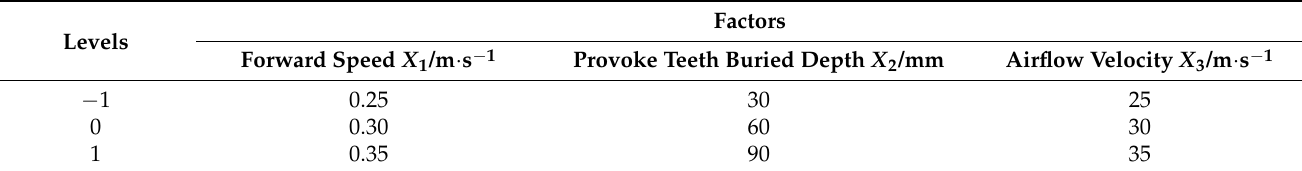
Table 2. Arrangements of the test factors and levels with the Box–Behnken method.